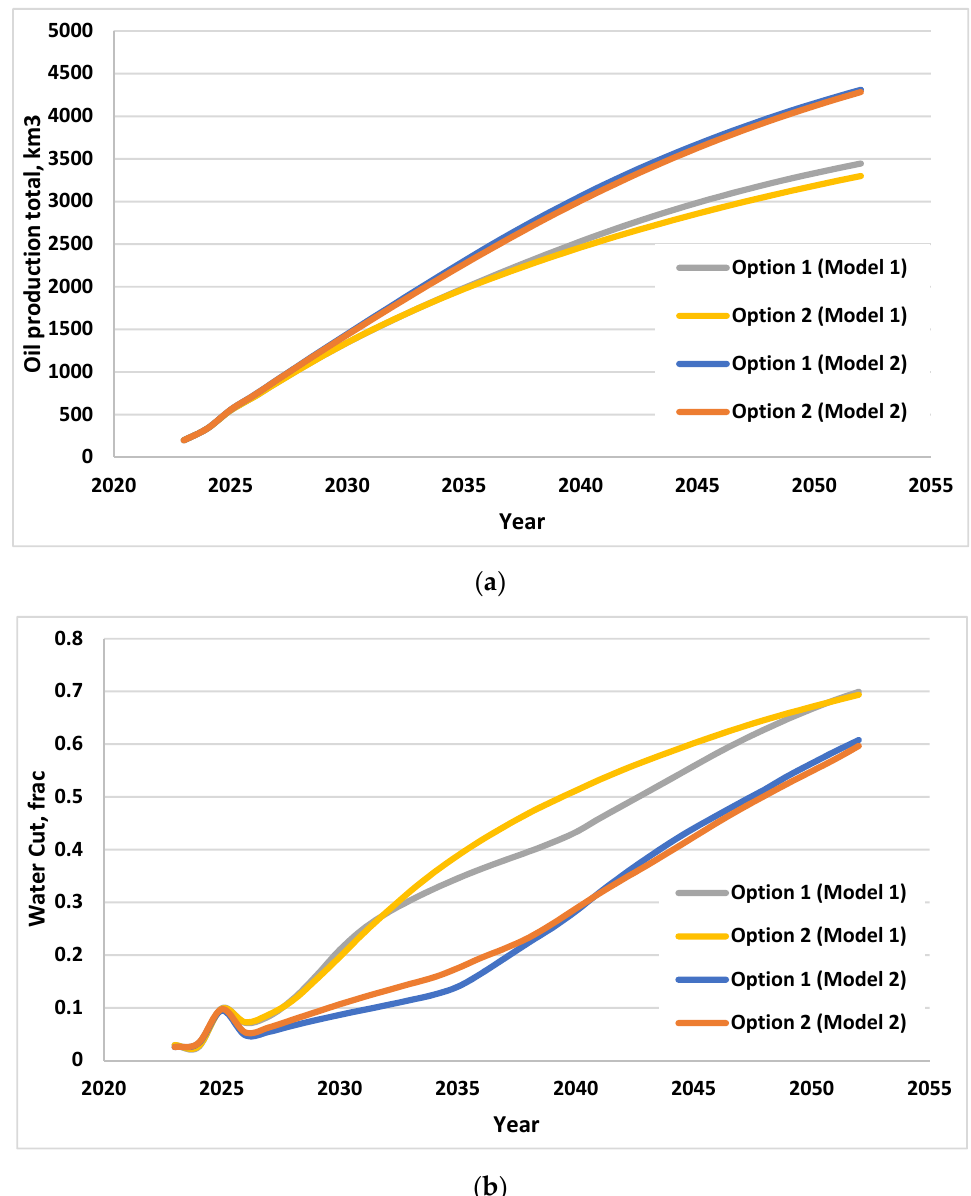
Figure 8. Development strategies: ( a ) oil production, total, ( b ) water